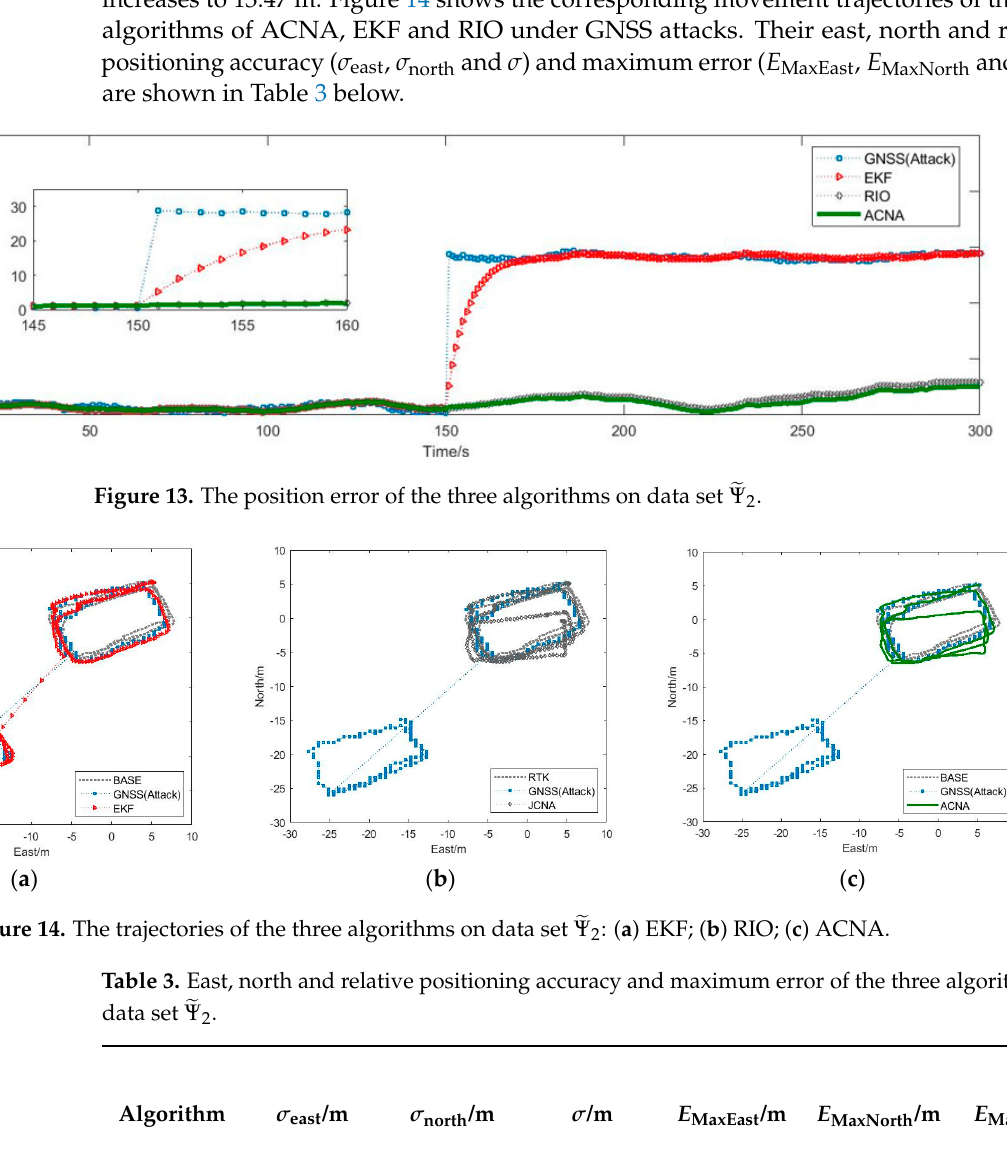
Figure 12. The impact of slow-change parameter settings: ( a ) the impact of slow-change verification window; ( b ) the im- pact of slow-change verification threshold ( s =5 n ).